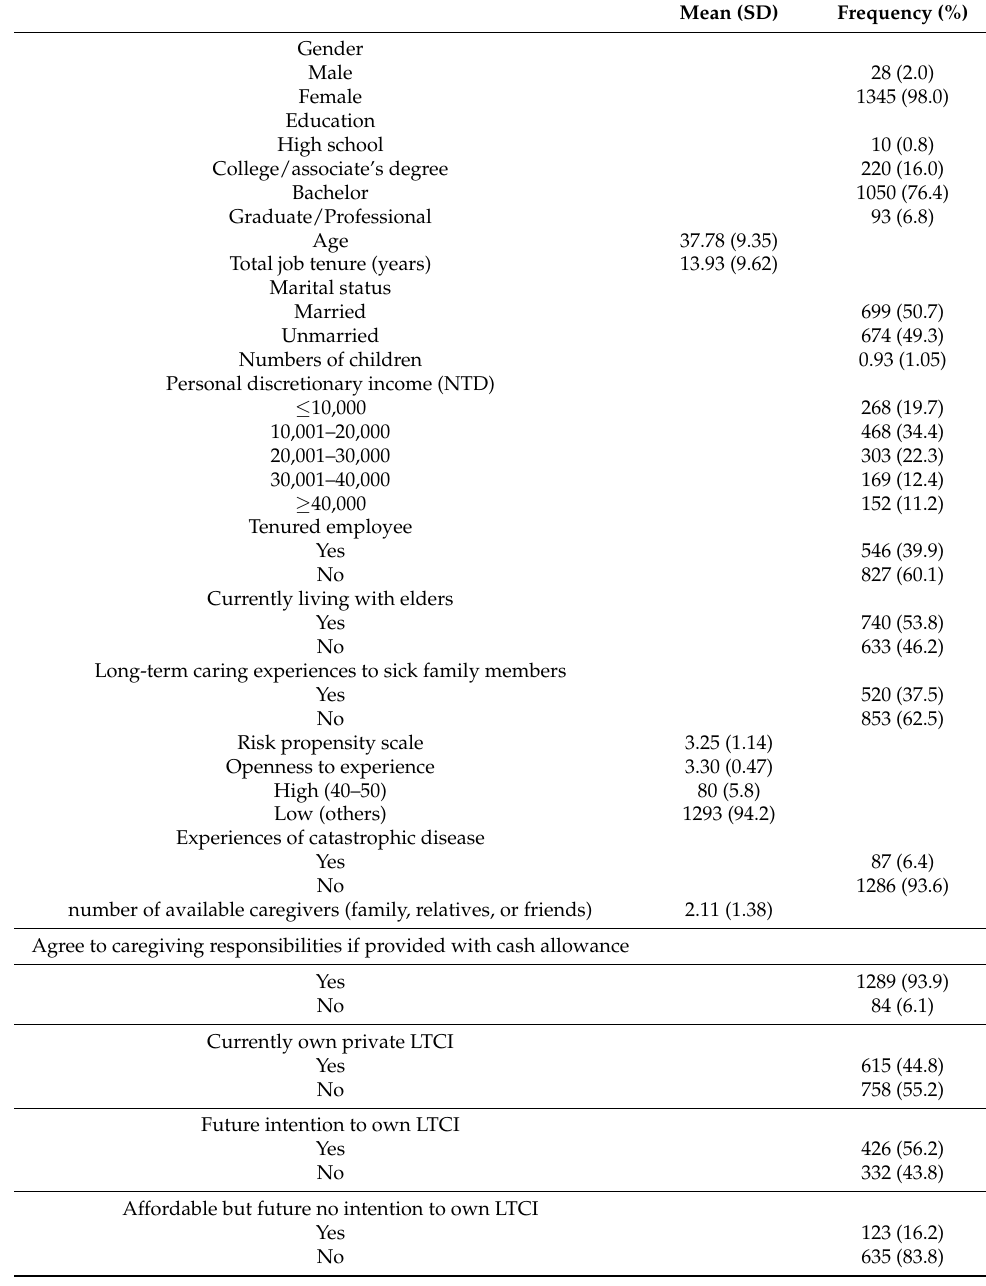
Table 1. Descriptive characteristics of